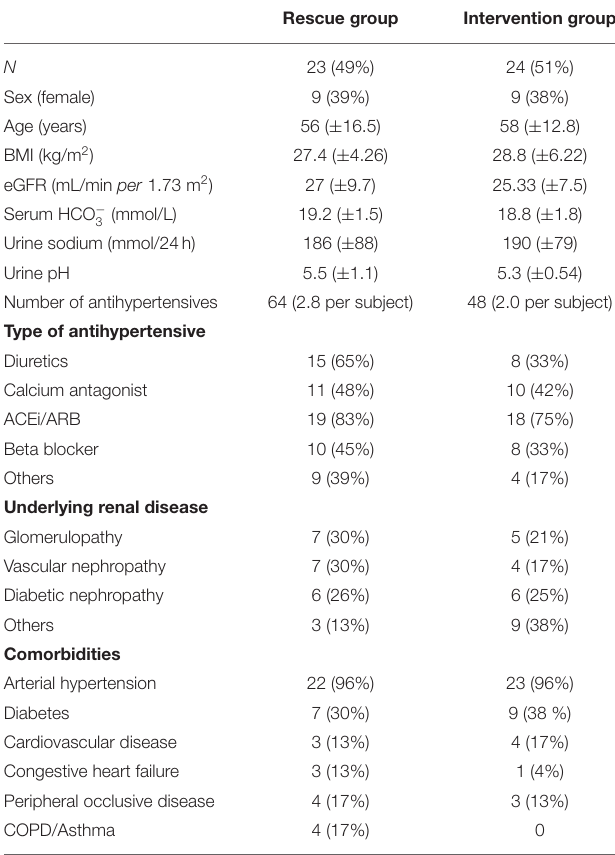
TABLE 1A | Basic demographic data at baseline [count (percent) and mean (standard deviation), respectively] with respect to study